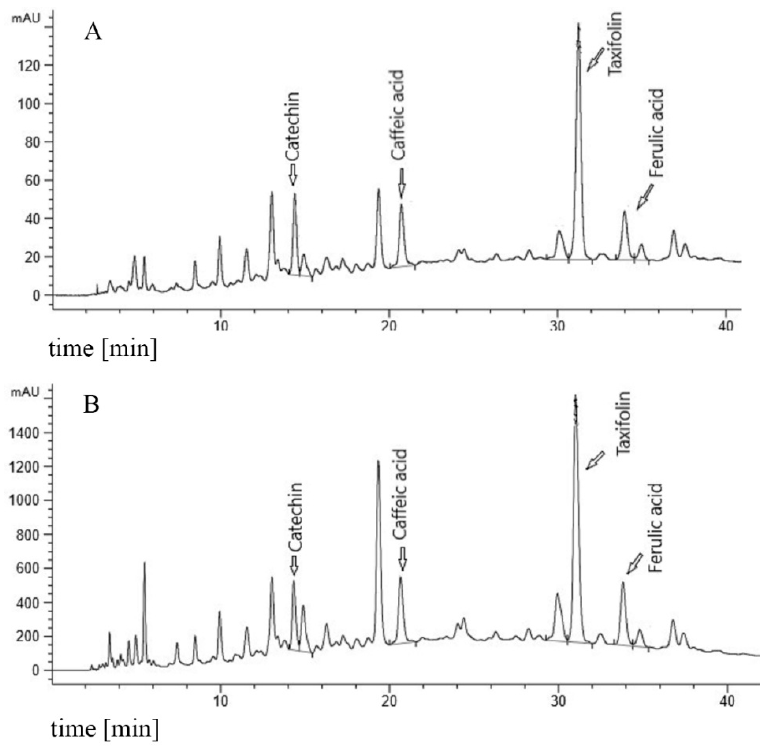
Table 1. Solubility of catechin, caffeic acid, taxifolin, and ferulic acid at different concentrations of PYC (1, 4 and 50 mg/mL) in PBS (Phosphate Buffered Saline) referred to solubility in methanol (=100%) determined by high-performance liquid chromatography (HPLC).